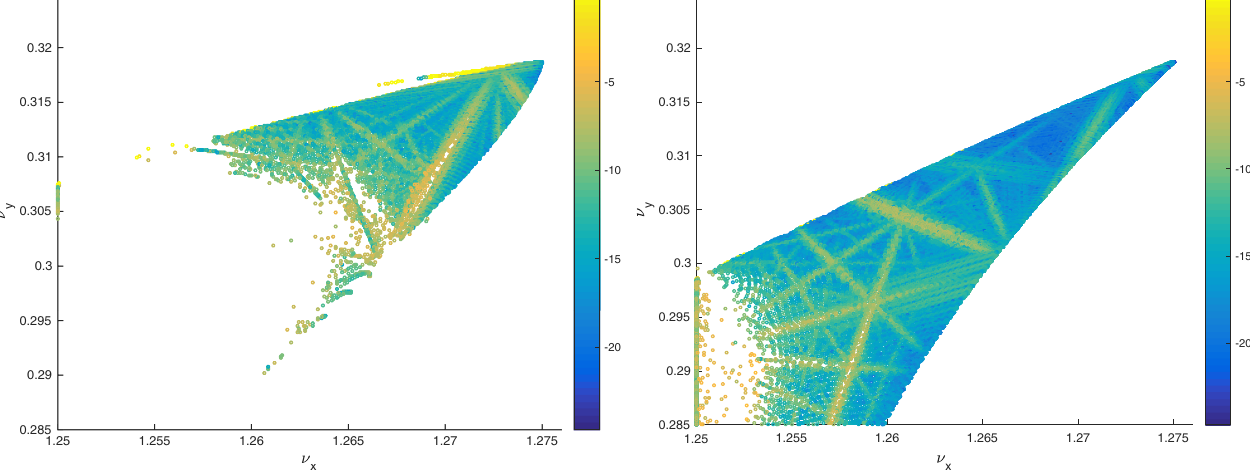
FIG. 14. Frequency map analysis of the beam footprints in the betatron tune plane without (left) and with (right) harmonic sextupoles. The color represents a diffusion rate in the logarithmic